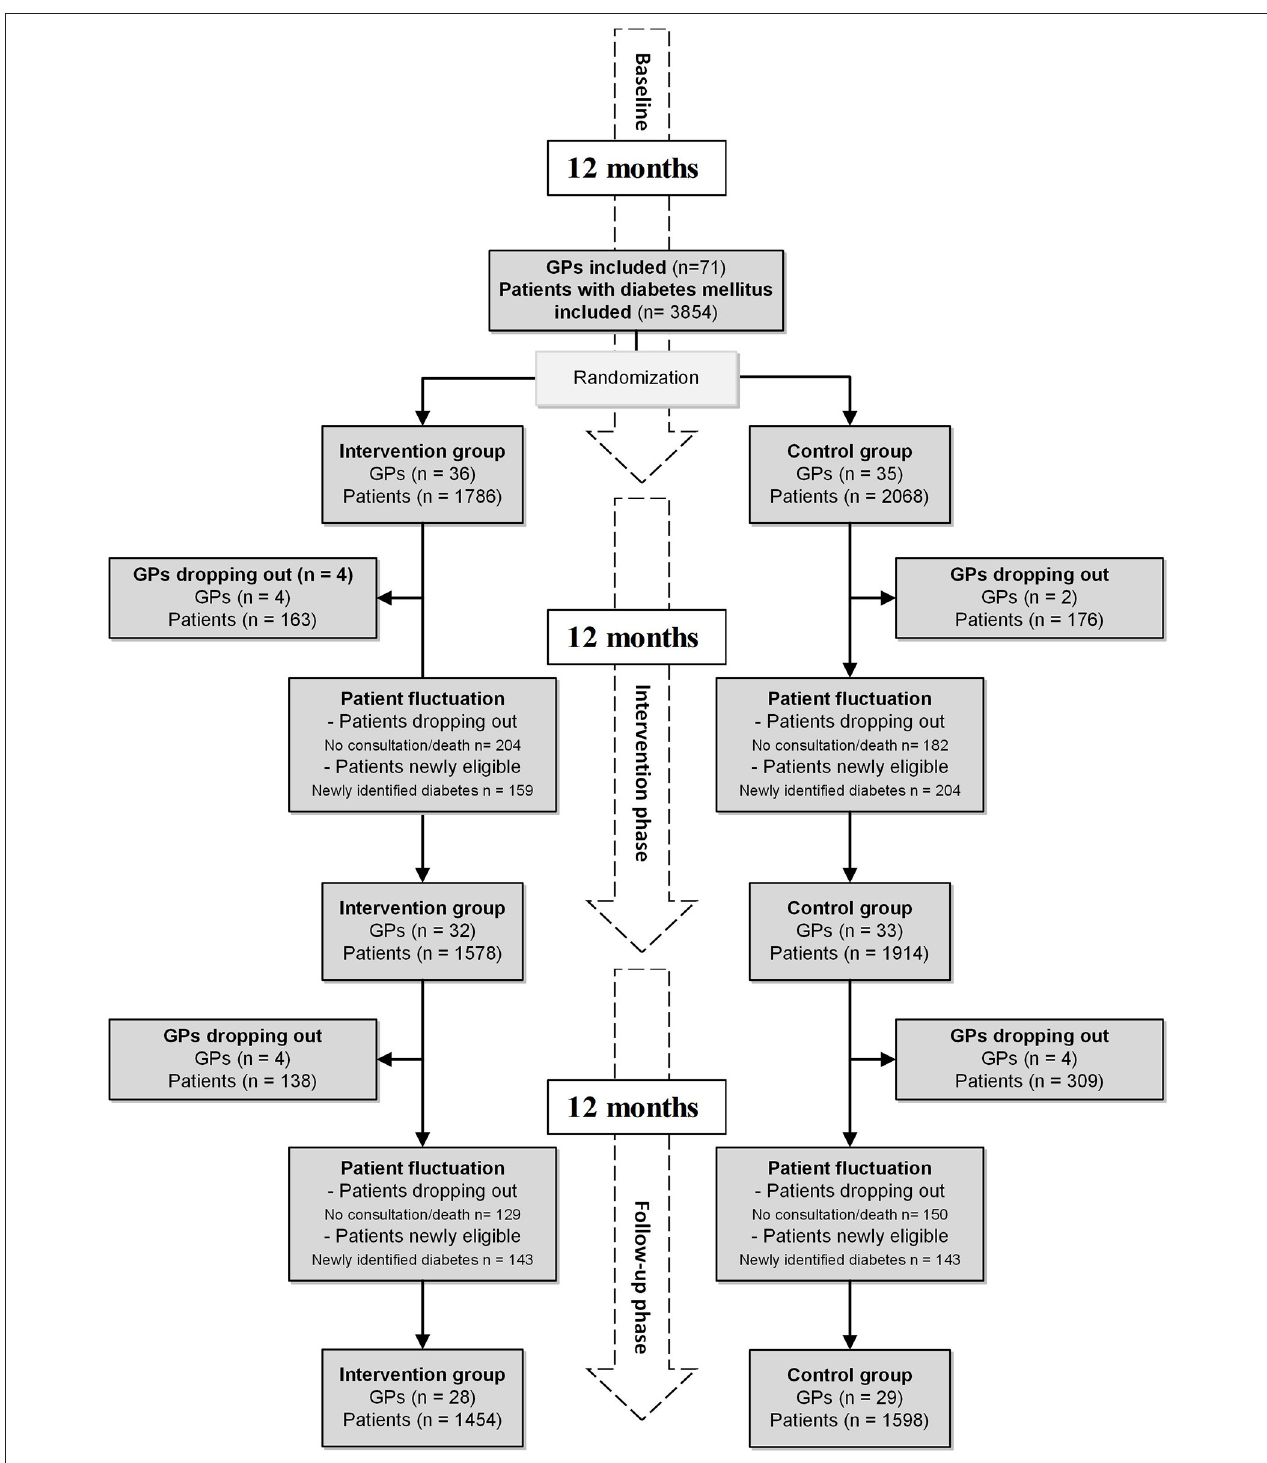
FIGURE 1 | Flowchart of the study, including dropouts of GPs and patient fluctuation. Financial incentives were stopped after the intervention phase. GP, general practitioner.